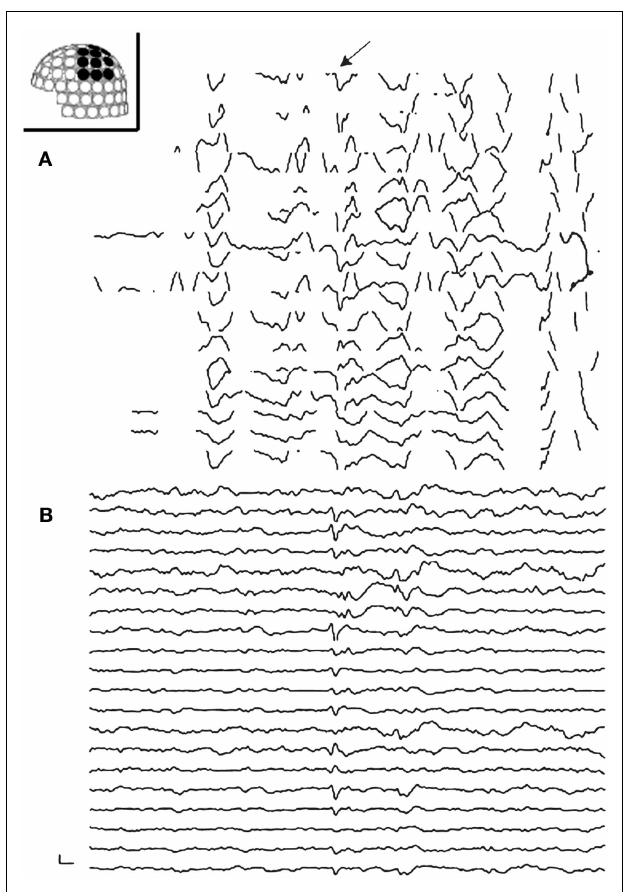
FIGURE 2 | Preprocessing of MEG with tSSS . Panels show MEG waveforms in the left centroparietal sensors recorded on a patient with vagus nerve stimulator (VNS).VNS artifacts contaminate the MEG data (A) . MEG processed with tSSS shows a prominent spike-and-wave complex (B)